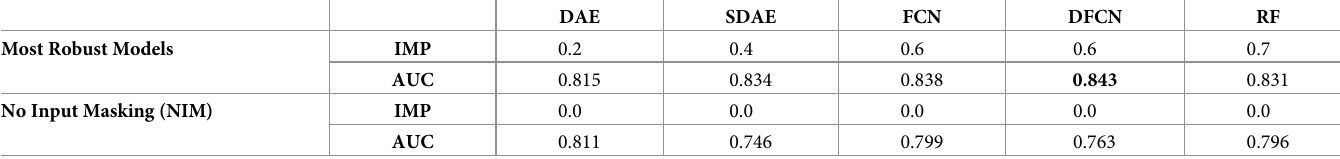
Table 2. Results on validation set data. Five models are trained using various input masking probabilities ( IMP ). Each resulting model is validated using the heavily masked validation dataset of 13596 samples (5668 positive) to evaluate their performance in the context of missing input data. AUC values for the optimal training IMP are shown, along with those achieved with no input masking ( NIM ). Bold font indicates the highest AUC in the table. Results for other IMP values are provided in the S1